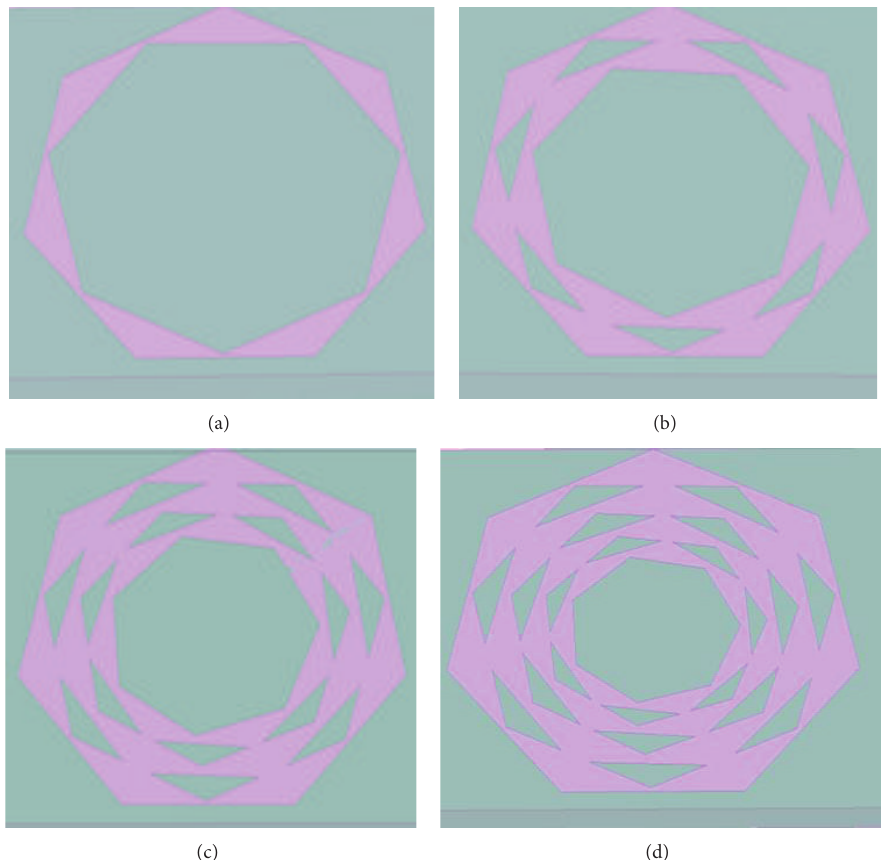
Figure 1: Heptagonal arrays: (a) base shape, (b) 1st iteration, (c) 2nd iteration, (d) 3rd iteration.